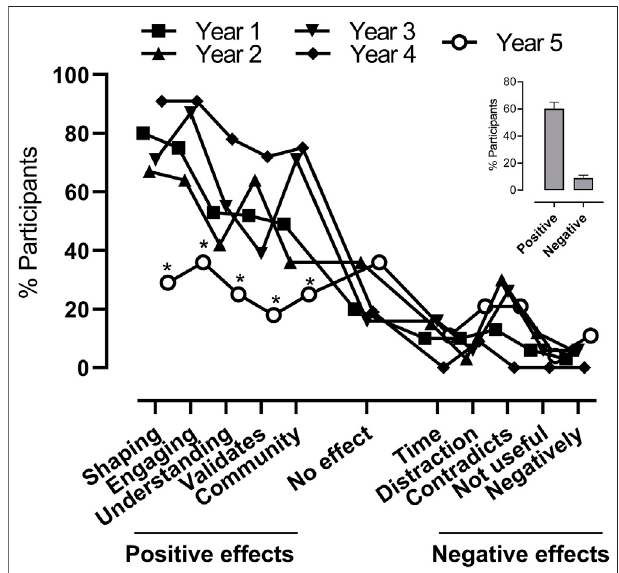
FIGURE 1 | Monastic students ’ perceptions on effects of learning scienceatSeraJeyMonasticUniversity(2018study)Insummer2018,Tibetan Buddhist monastic students reported a robust appreciation for the positive versus the negative effects of learning science on their Buddhist studies; determined by the frequency of survey responses as a percent of participants in each year ( n (cid:1) 214). Each symbol is representative of data from students in different years of the science curriculum. The words chosen as graph labels areunderlinedinthefullprompt( SupplementalA ,number7).Overallpercent of participants endorsing positive and negative perceptions are quanti fi ed in the